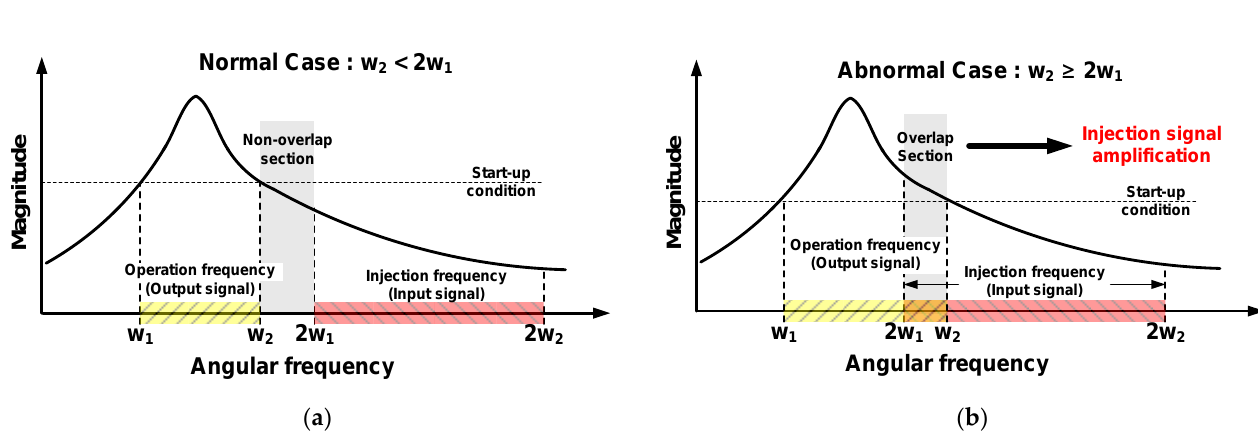
Figure 3. Graphs of magnitude of load impedance against angular frequency; ( a ) normal case, ( b ) abnormal case.